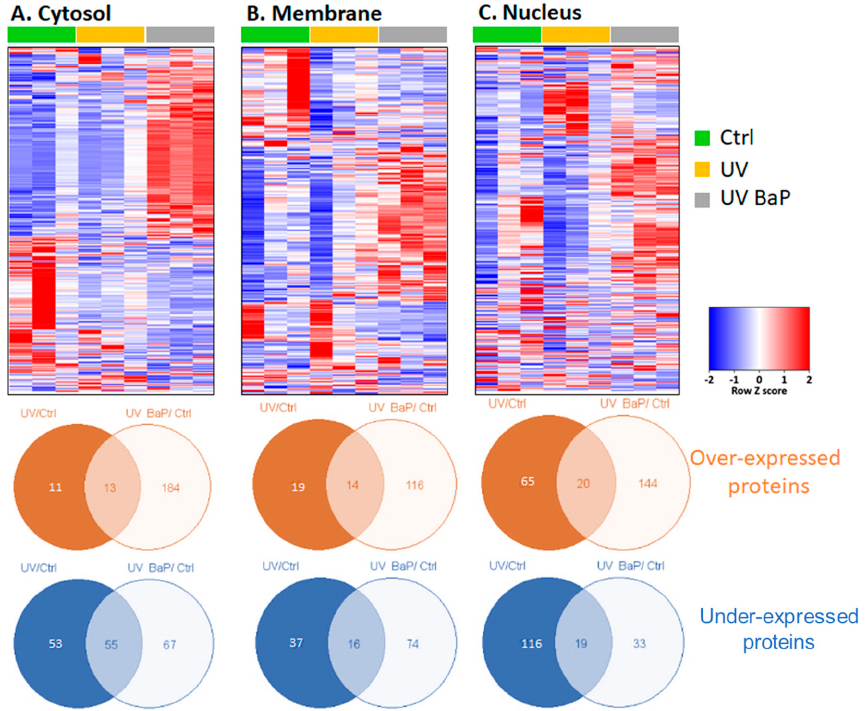
Figure 1. Dysregulation of proteins from the cytoplasmic ( A ), cell membrane ( B ) and nuclear ( C ) extracts of human skin explants exposed to UV light or UV light and BaP, compared to untreated cells (Crtl). Each heatmap represents the expression profile of dysregulated proteins upon UV exposure with or without a co-exposure to BaP, based on the z-score of the protein’s normalized peak area. Rows represent dysregulated proteins and columns represent the samples at different exposure conditions. The red color represents an overexpression while the blue color represents a down-regulation of the protein compared to the mean value of a protein from all samples. The z-score is a normalization score of each row and has the same range of color values. Heatmaps were built using the Funrich tool, version 3.1.3. For each Venn diagram, the number of proteins over-expressed ( p < 0.05; ≥ 1.5 fold) or under-expressed ( p < 0.05; ≤ 0.67 fold) is indicated for each sub-localization of cells.